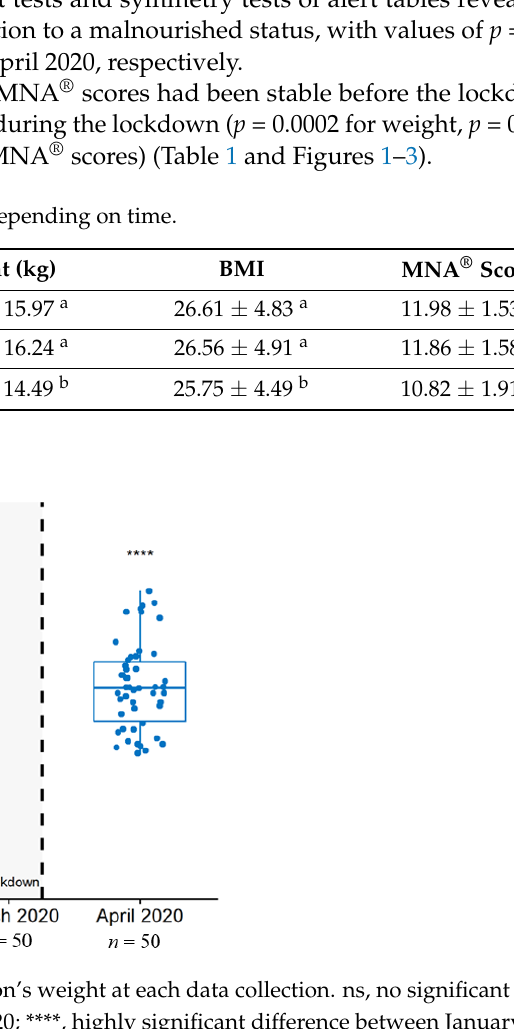
Figure 3. Boxplot depicting the population’s MNA ® score at each data collection. To better understand our subjects’ characterization, we considered a weight loss of ≥ 5% to be of concern, which concerned 11 persons versus 39 (22%). (Figure 4)